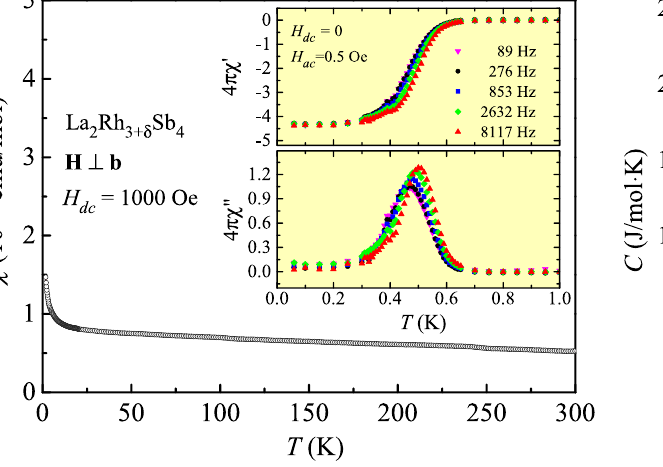
Figure 6. Temperature dependent specific heat ( C ) of La 2 Rh 3 + δ Sb 4 . The left inset shows a plot of C / T vs. T 2 in the low temperature range. The upturn of C / T for T → 0 arises from the nuclear Schottky anomaly. The bottom inset, ( C − C ph − C Sch ) / T as a function of T , displays the jump due to SC transition ∆ C / T | T = 6.5mJ mol − 1 · K 2 c